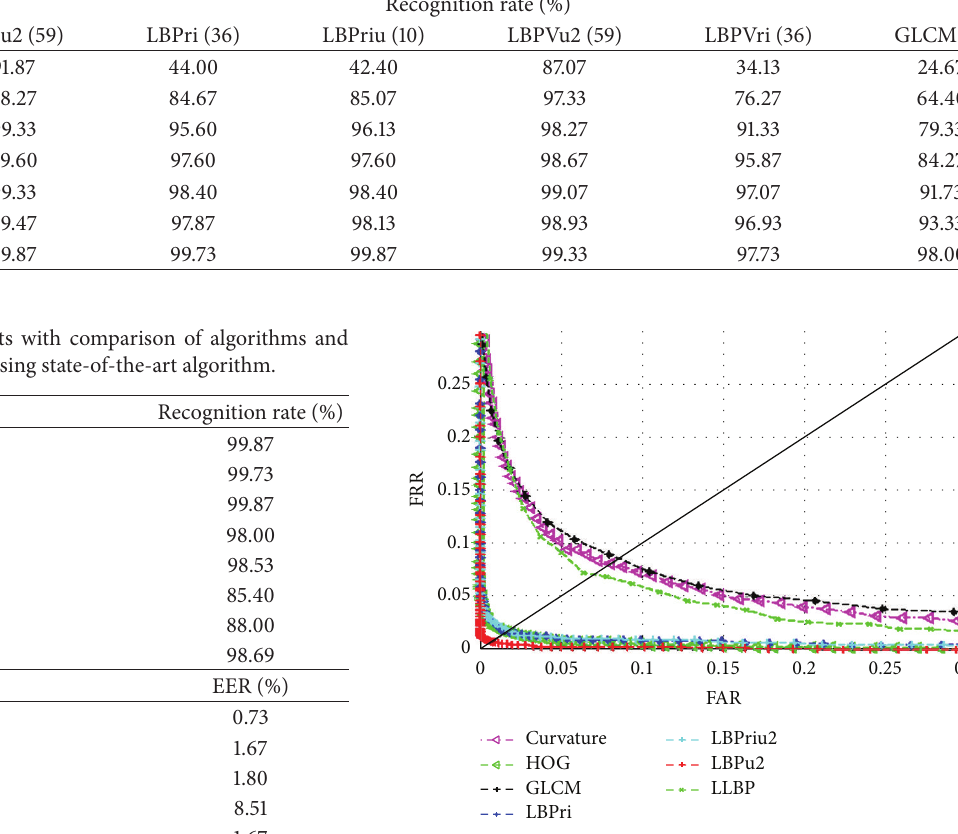
Figure 10: Comparison of ROC curves using state-of-the-art algo-